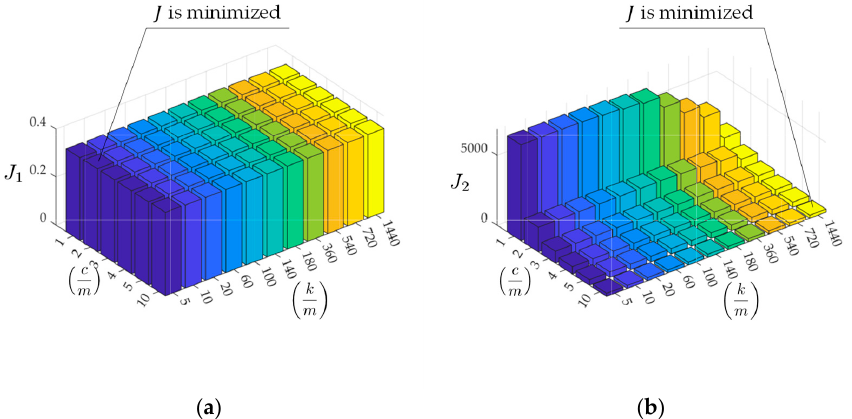
Figure 14. The values of objective functions: ( a ) based on Equation (9); ( b ) based on Equation (15). According to Figure 14, as the mechanical parameters (cid:4672) (cid:3030)